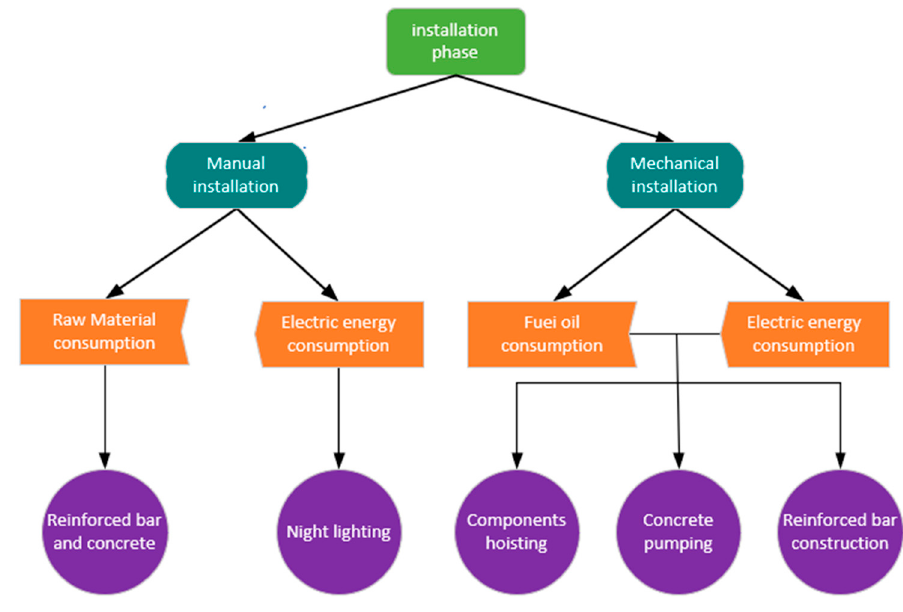
Figure 4. Carbon emissions sources of prefabricated components during the installation stage.